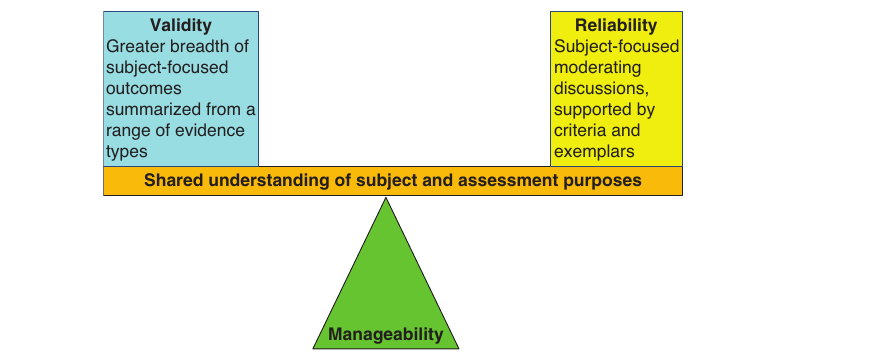
Figure 3: Phase 3 summative teacher assessment seesaw: Focus on